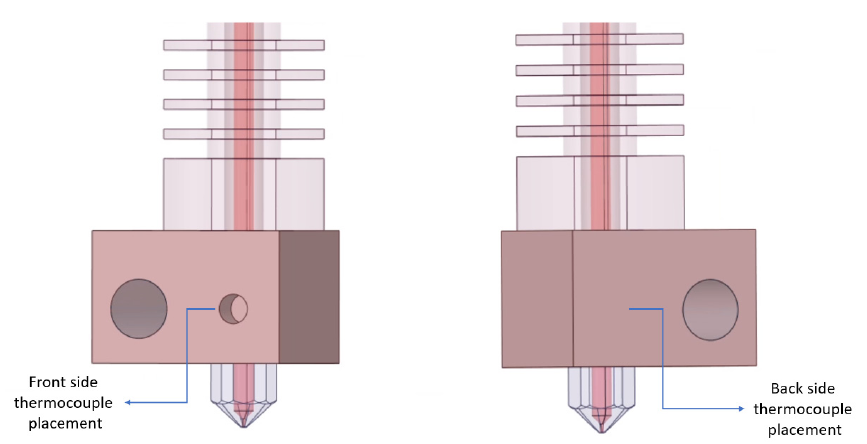
Figure 6. Placement of the external thermocouples for validating the temperature profile of the forced convection simulation.